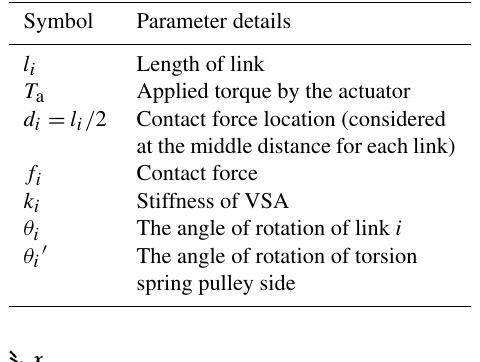
Table 2. Parameters of CPRF analysis.